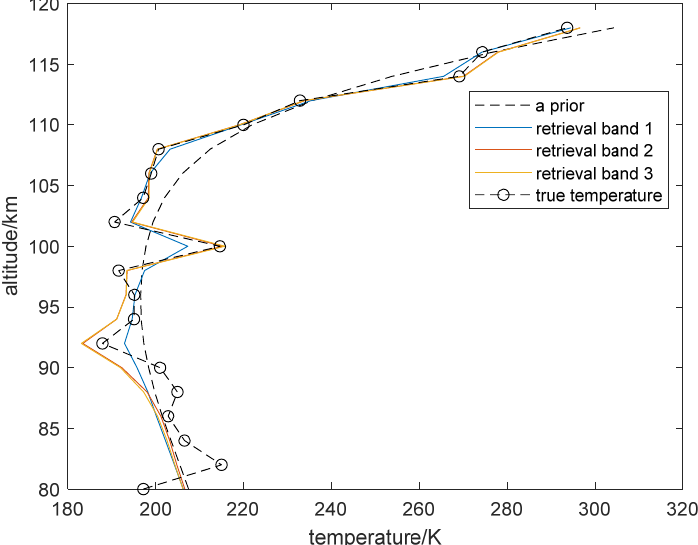
Figure 15. Retrieval of atmospheric temperature in MLT region based on different bands.